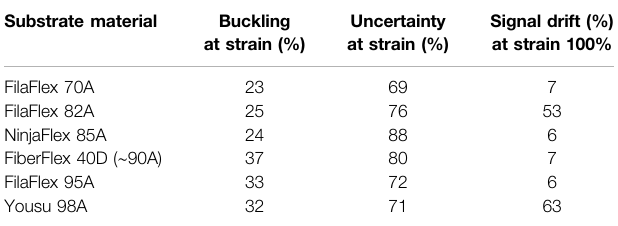
TABLE3| Strainvalueswherebucklinganduncertaintycanbeoverservedaswell